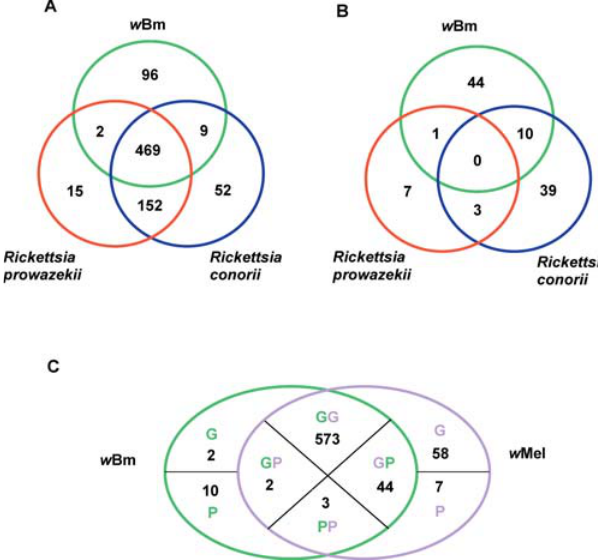
Figure 2. Venn Diagram Showing Comparison of Conserved and Unique Genes and Pseudogenes in w Bm (Wolbachia from B. malayi), Rickettsia prowazekii, Rickettsia conorii, and in w Bm and w Mel (among Those Assigned to COGs) (A) Predicted functional protein-coding genes. (B) Pseudogenes. (C) Combined results for comparison between wBm and w Mel. G, intact gene; P, pseudogene. DOI: